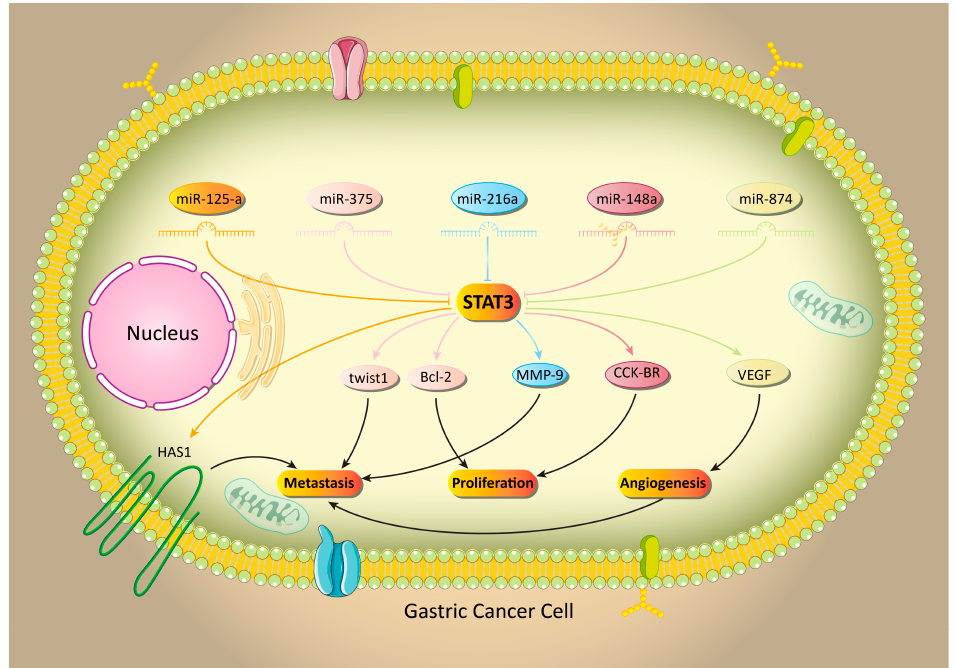
Figure 2. Onco-suppressor microRNAs in the inhibition of STAT3 and the malignant behavior of gastric cancer cells. Biology 2020 , 9 , 126